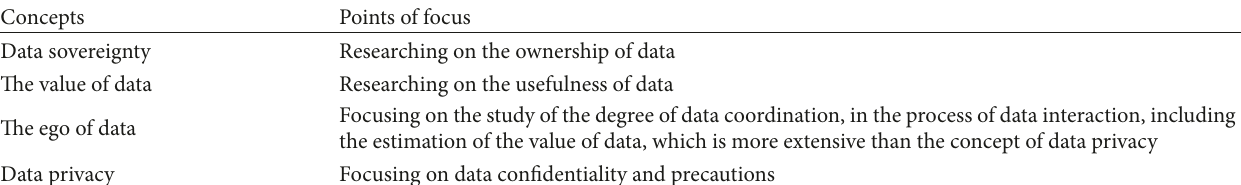
Table 1: The connection and difference between the ego of data and several